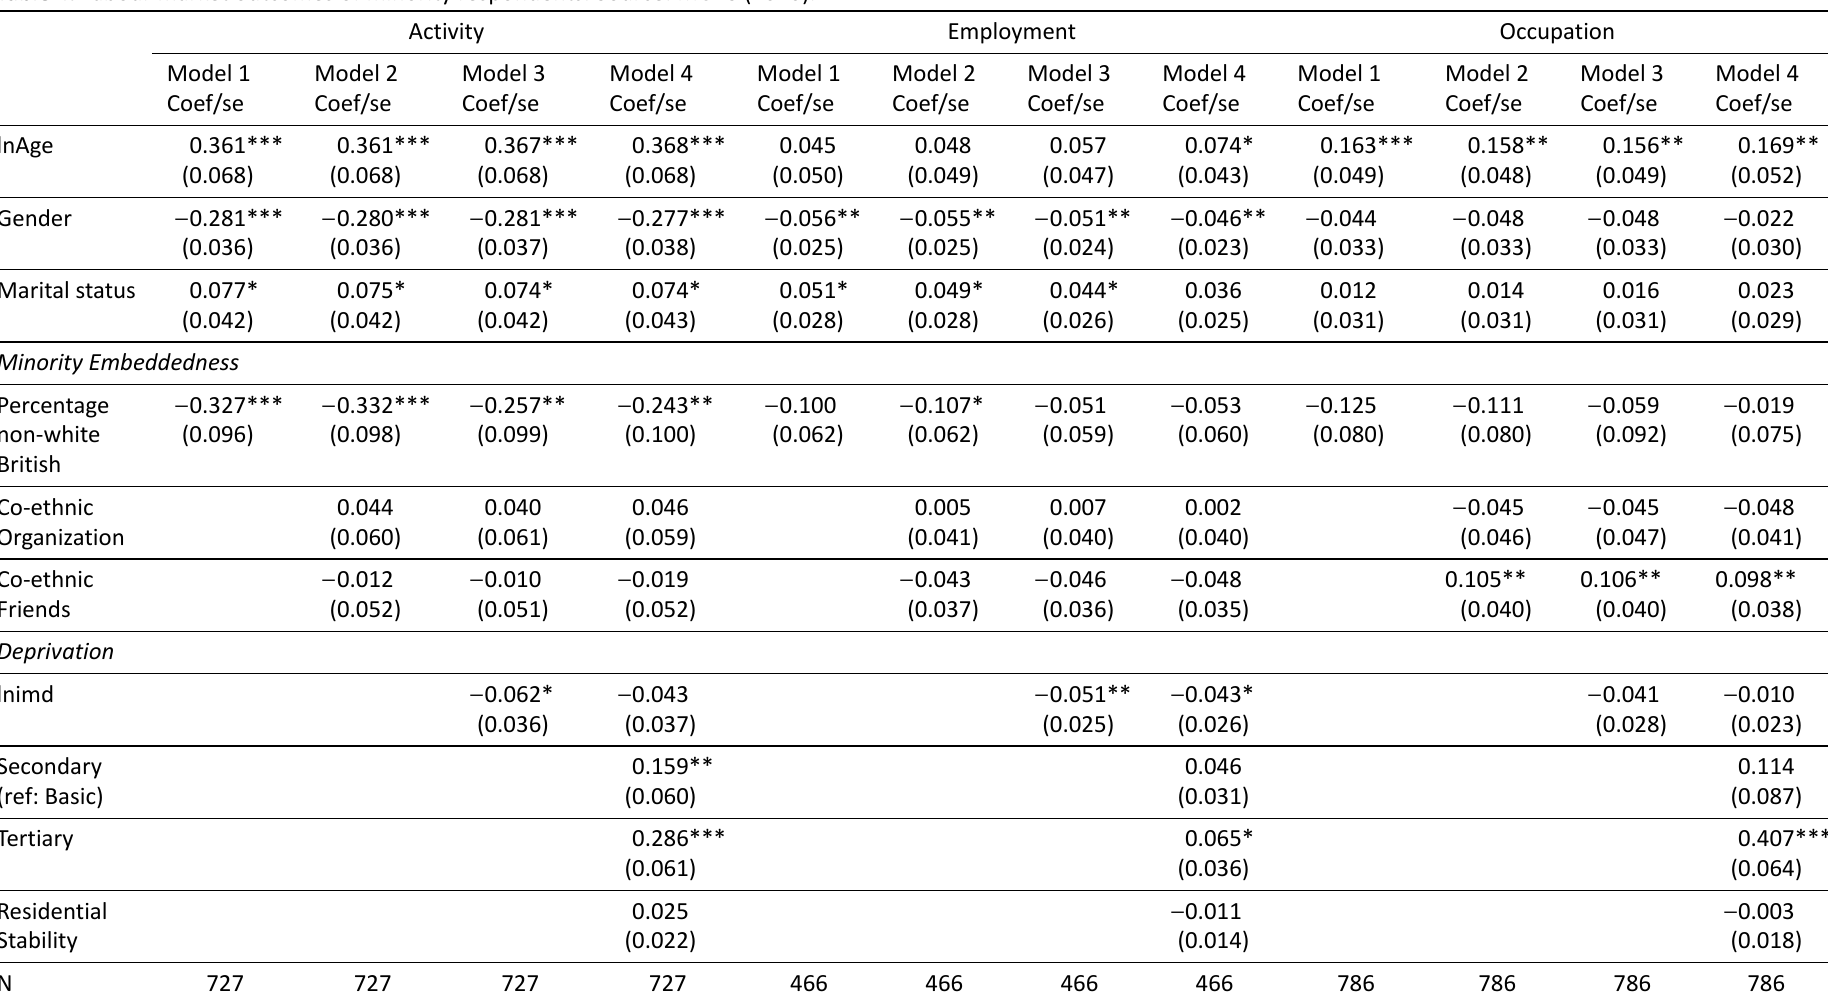
Table 4. Labour market outcomes of minority respondents. Source: MCDS